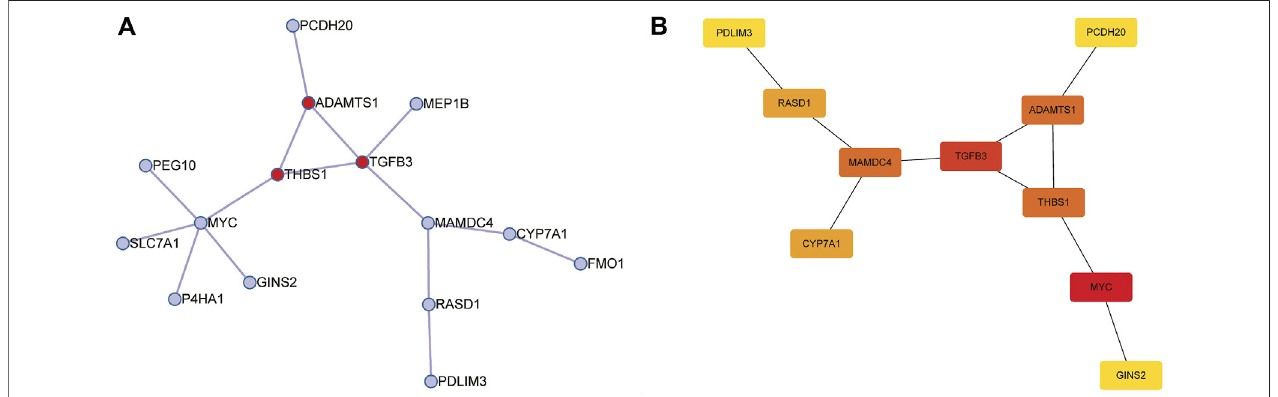
FIGURE5| Constructionofprotein-proteininteraction(PPI)networksfor25trait-expression-related genesintheMetascapedatabase. (A) PPInetworkof15trait- expression-relatedgenes.RednoderepresentedtheMolecularComplexDetection (MCODE)algorithmappliedtoidentifydenselyconnectednetworkcomponents. (B) Results of the CytoHubba plugin; the color changed from yellow to red was indicative of the rank of protein, and the deeper the red staining, the higher rank of protein